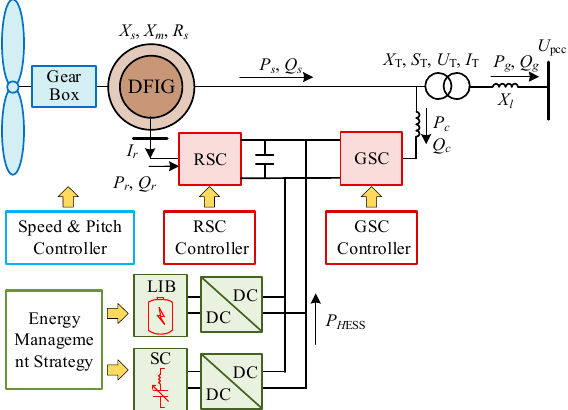
Figure 1. The overall structure system of the DFIG with HESS.